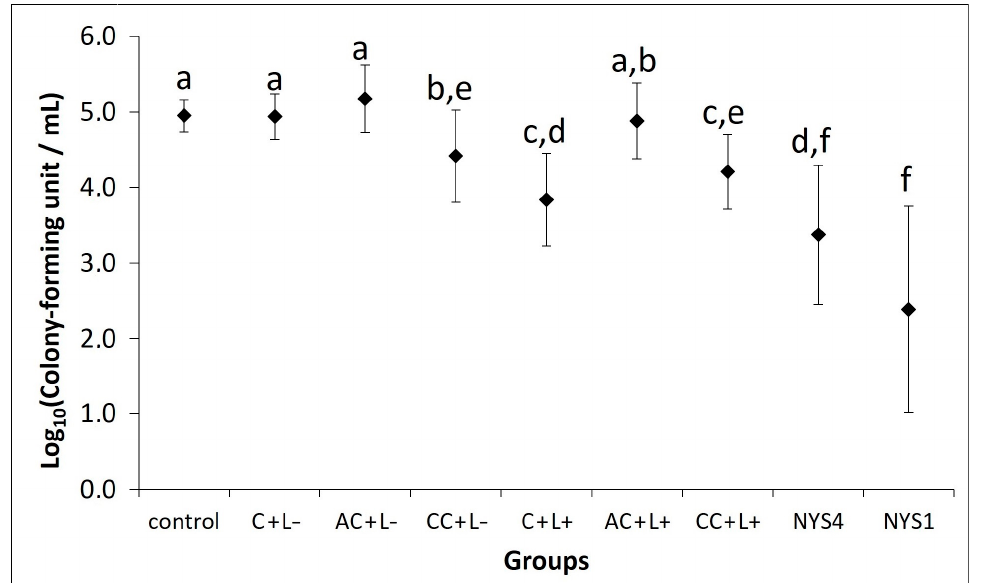
Figure 5. Mean values of log 10 (CFU/mL) of C. albicans recovered from the tongue dorsum on the last day of treatment ( n = 24). The control group corresponded to infected animals that did not receive any treatment (C − L − ); C + L+, AC + L+, and CC + L+ groups: animals treated with free CUR, and anionic and cationic CUR-NP, respectively, associated with blue LED light; C + L − , AC + L–, and CC + L − groups: evaluation of each PS alone (free CUR, anionic and cationic CUR-NP, respectively); NYS1 and NYS4 groups: animals treated with Nystatin 100,000 international units (IU) once (under anesthesia) and four times daily, respectively. Different letters represent statistical differences between the groups ( p < 0.05). Error bars: standard deviation.